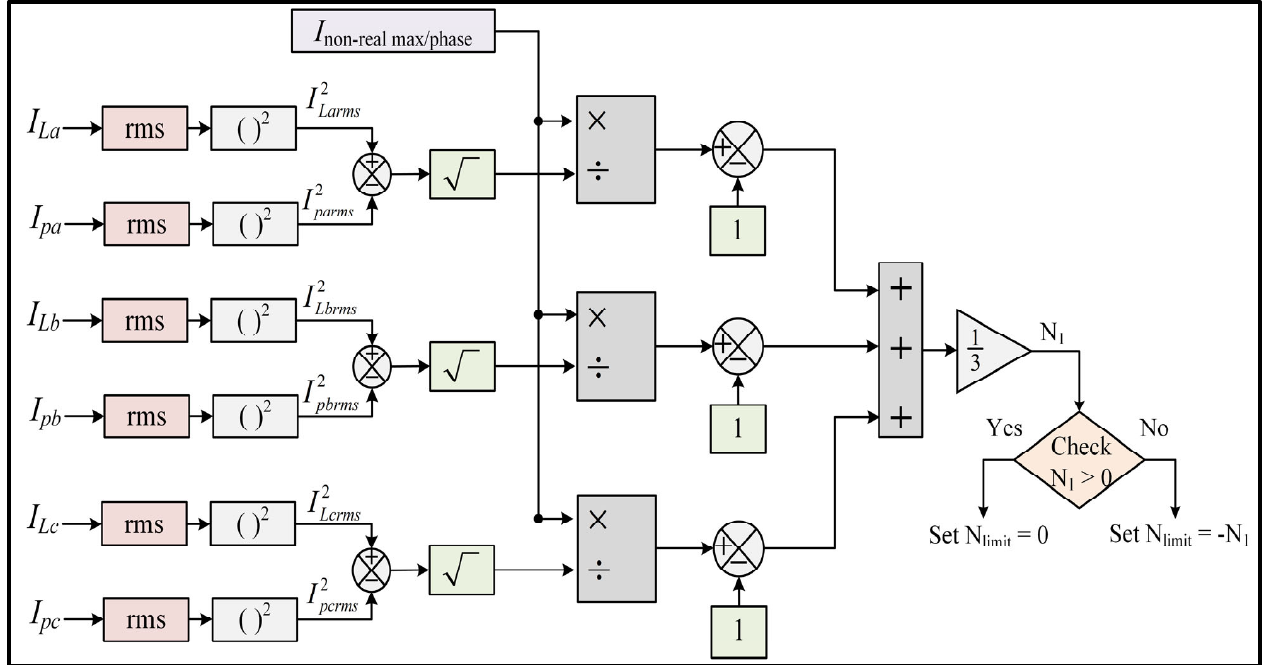
Figure 3. Block diagram for determination of N limit .